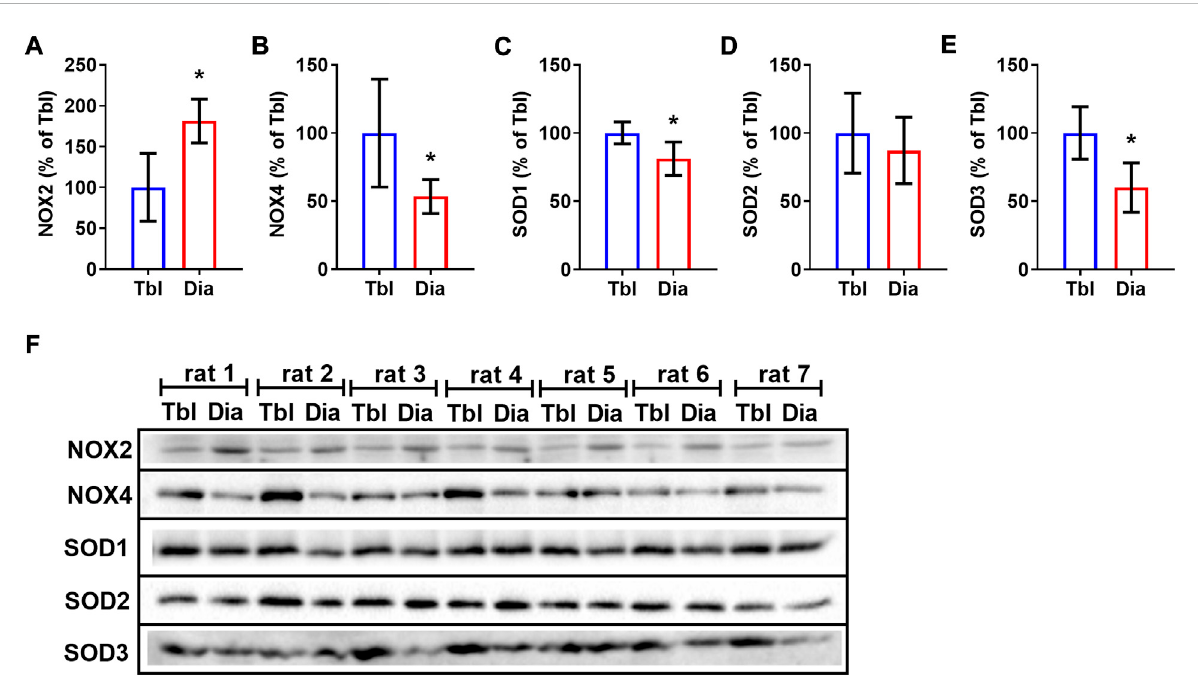
FIGURE 5 Rattricepsbrachiimuscle anddiaphragm muscledifferinthecontentsofNOX andSOD isoforms. TherelativecontentsofNOX2 (A) ,NOX4 (B) , SOD1 (C) , SOD2 (D) , SOD3 (E) in triceps brachii muscle long head (Tbl, n = 7) and diaphragm muscle (Dia, n = 7) of sedentary rats (A – E) . Representative Western Blot images of NOXs and SODs isoform content in triceps brachii muscle and diaphragm muscle in sedentary rats (F) . * p < 0.05 compared to Tbl (unpaired Student ’ s